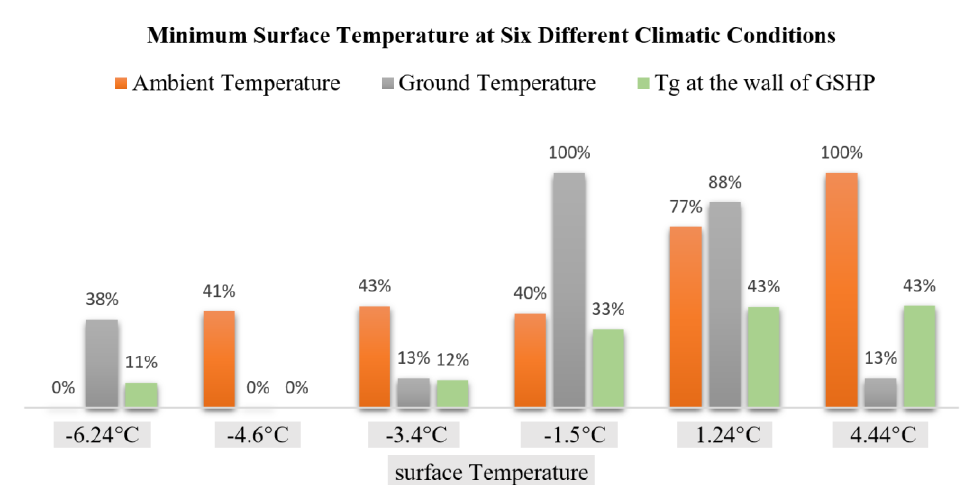
Figure 13. Normalized GSHP simulation results to compare effects of ambient temperature, ground temperature, and heat pipe wall temperature.